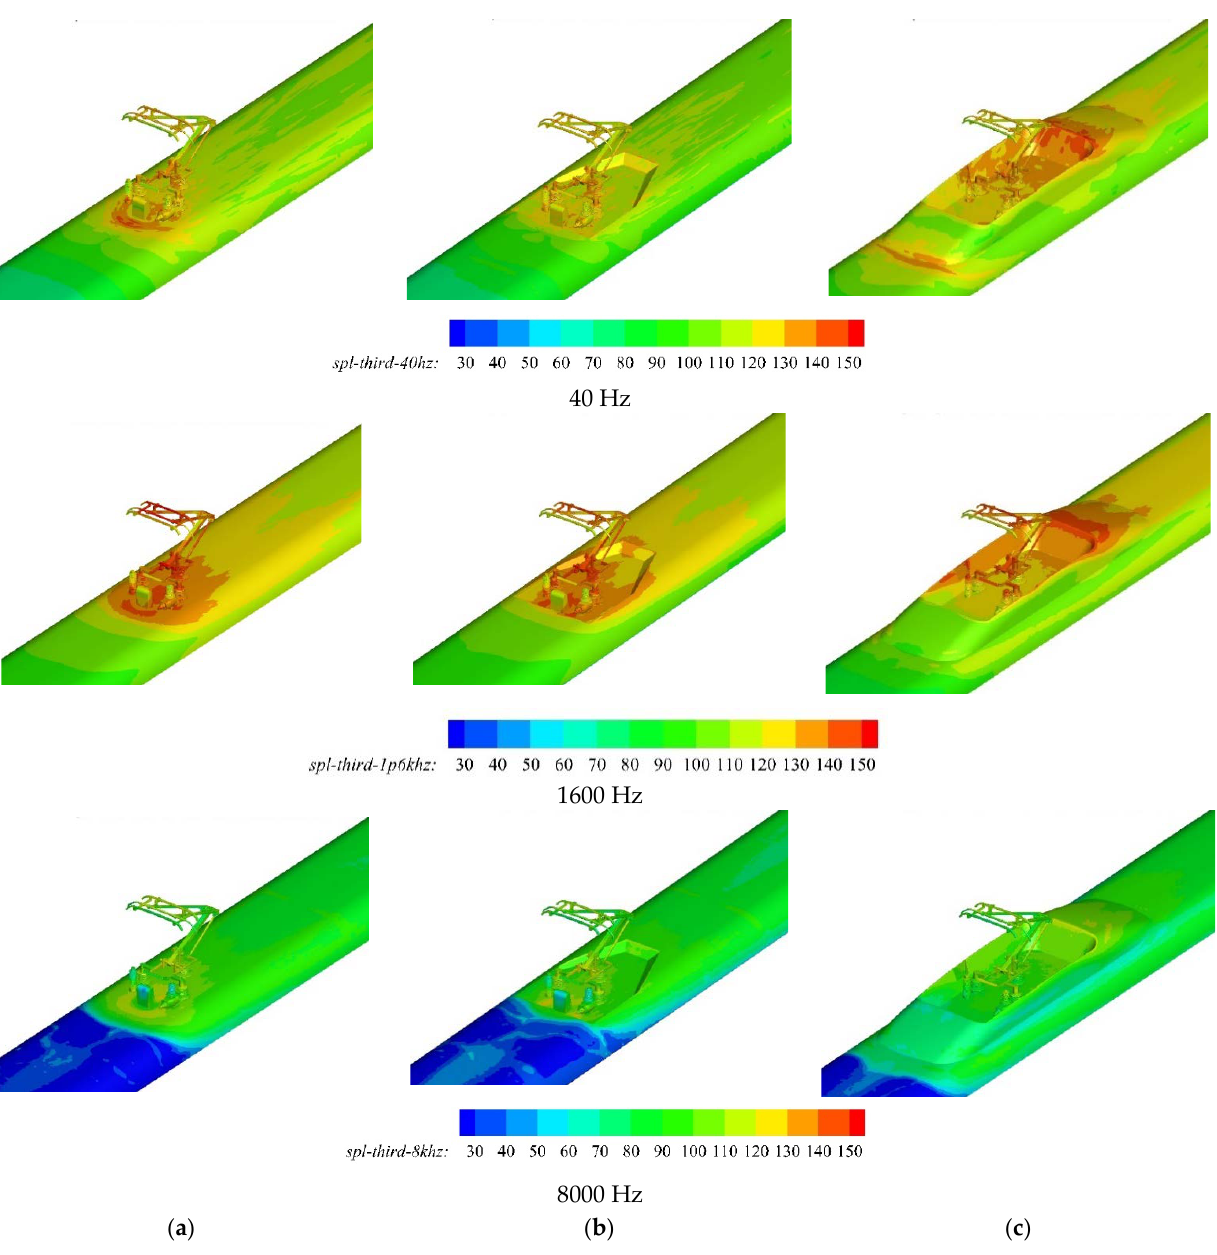
Figure 15. Sound source intensity at 40, 1600, and 8000 Hz. ( a ) Case 1; ( b ) case 2; ( c ) case 3.